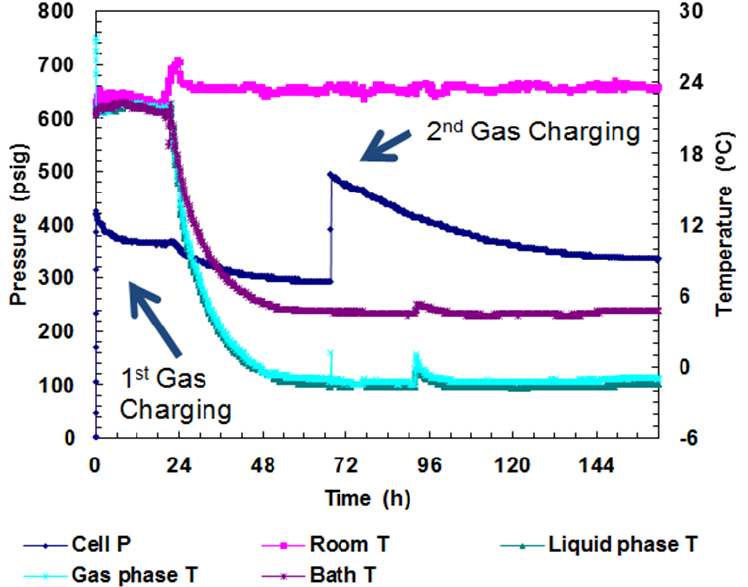
Figure 3. P/T versus time data plot during gas charging and hydrate formation in Run 1. Cell volume: 198 mL; Water: 75 mL; SDS: 300 ppm; Bath T: +5